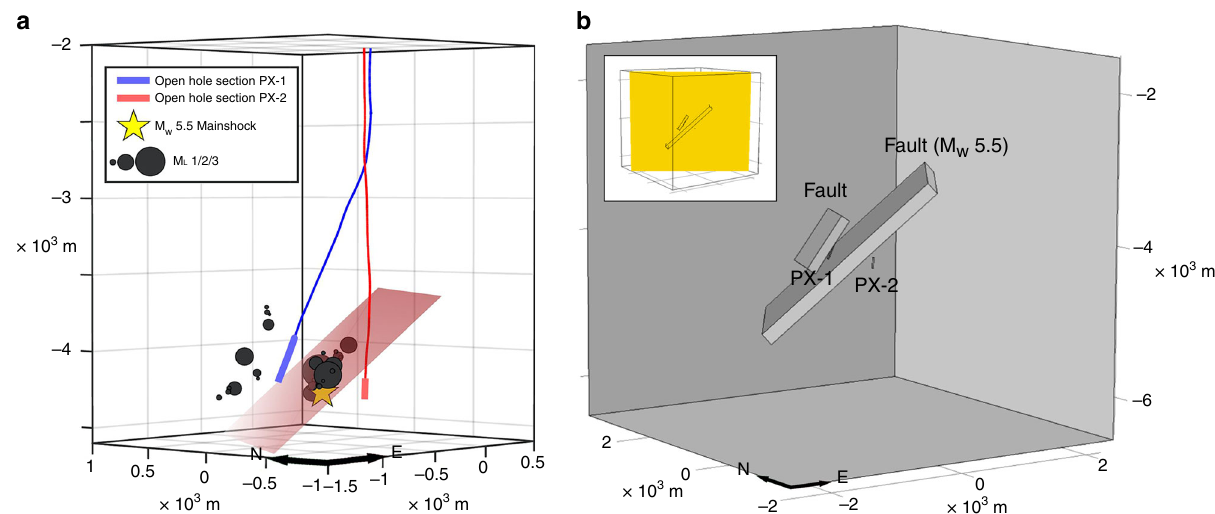
Fig. 4 Pore pressure model setup. The model dimensions, locations of injection intervals of PX-1 and PX-2, and two faults identi fi ed by seismicity are included. a Shows earthquake locations relative to PX-1 and PX-2 as well as the M w 5.5 fault plane (red rectangle). b Model dimensions and fault locations. Inset shows cross-section location (yellow rectangle) for main part of fi gure and results in Fig. 5 21